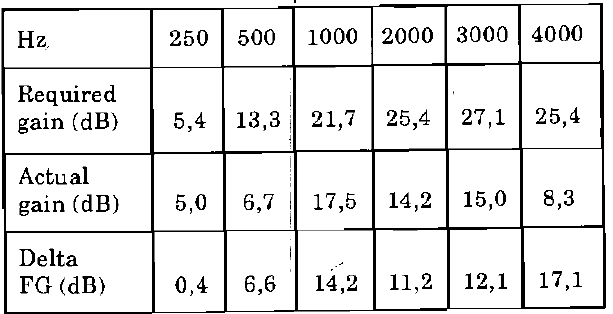
Table 2. The aided mean of ideal and actual func- tional gain at each frequency, and differences be- tween them before modifications.